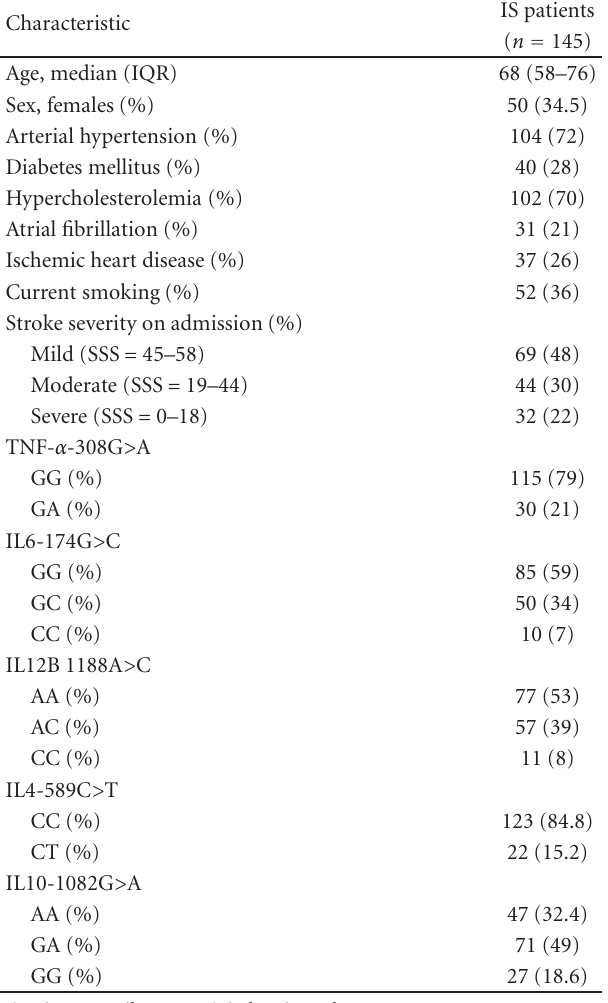
Table 3: Statistics of the disease-free survival analysis. Disease-free survival